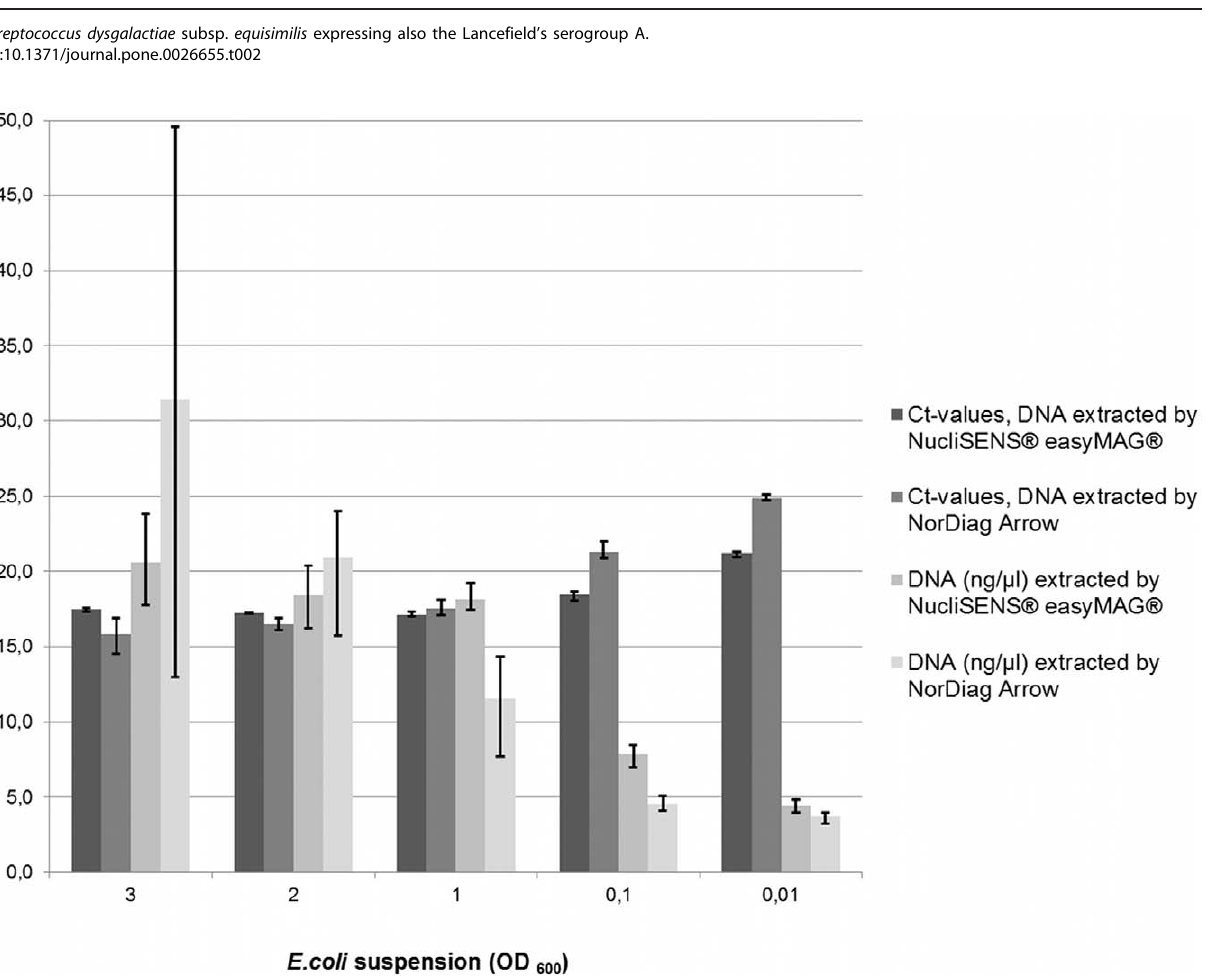
Figure 1. Comparison of the DNA yields of extracted E.coli DNA. Average values and their standard deviations of the three replicated subsamples of E.coli DNA extracts are presented in the columns. Columns are classified by the optical density values (OD 600 ) of the E.coli suspensions measured prior to DNA extraction. DNA concentrations (ng/ m l) were measured by a spectrophotometer and Cycle treshold (C t ) -values are based on the real-time